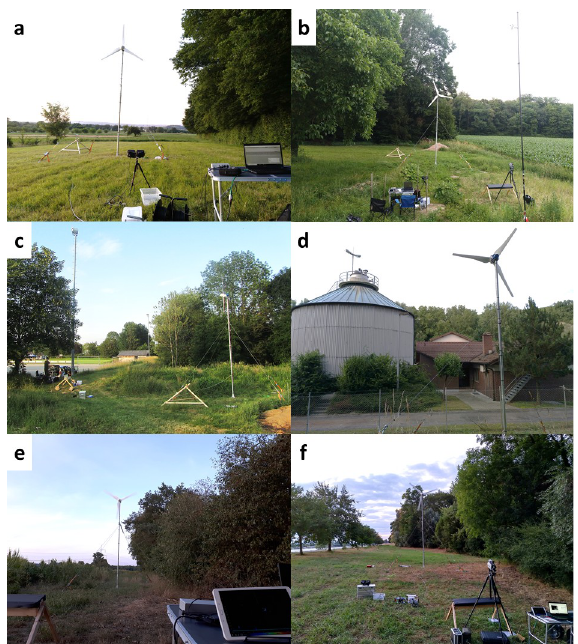
Fig 1. Site selection. Overview of the six sites (a–f) used in the experimental set-up.